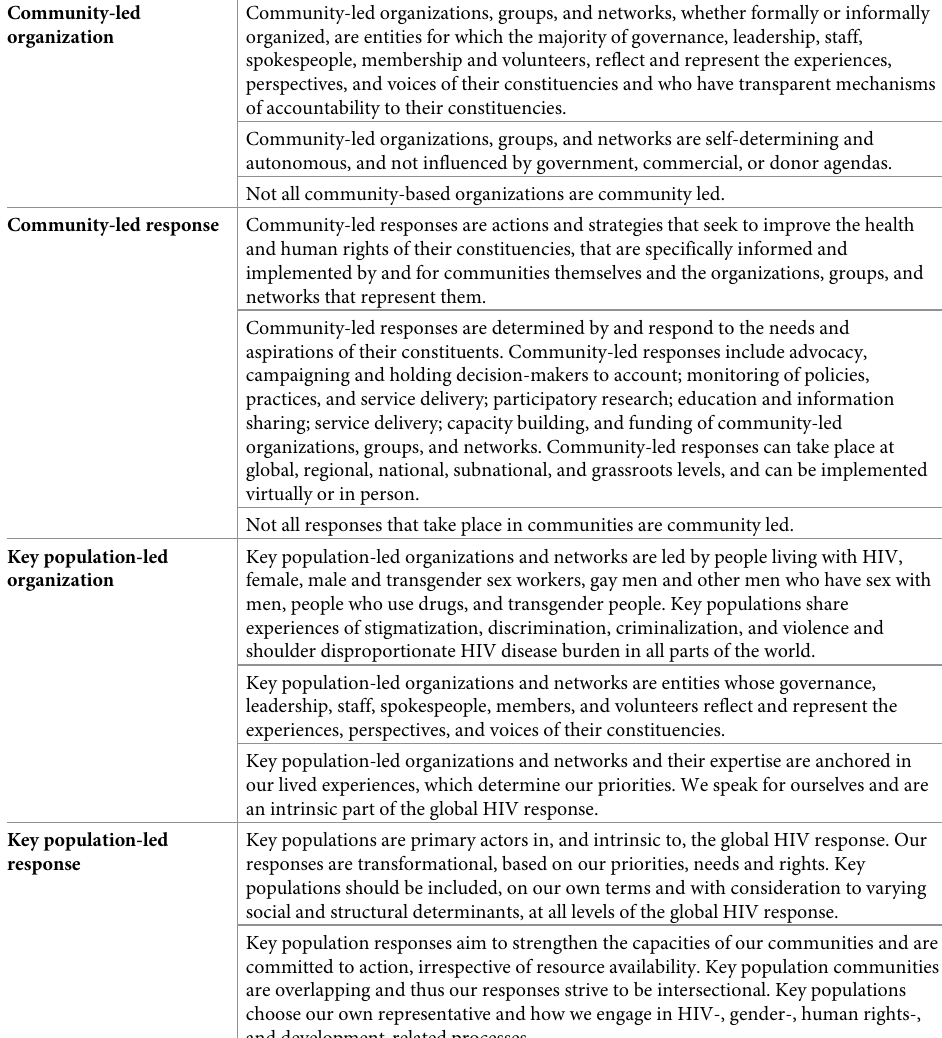
Table 1. Definitions resulting from the Montreux experts consultation, June